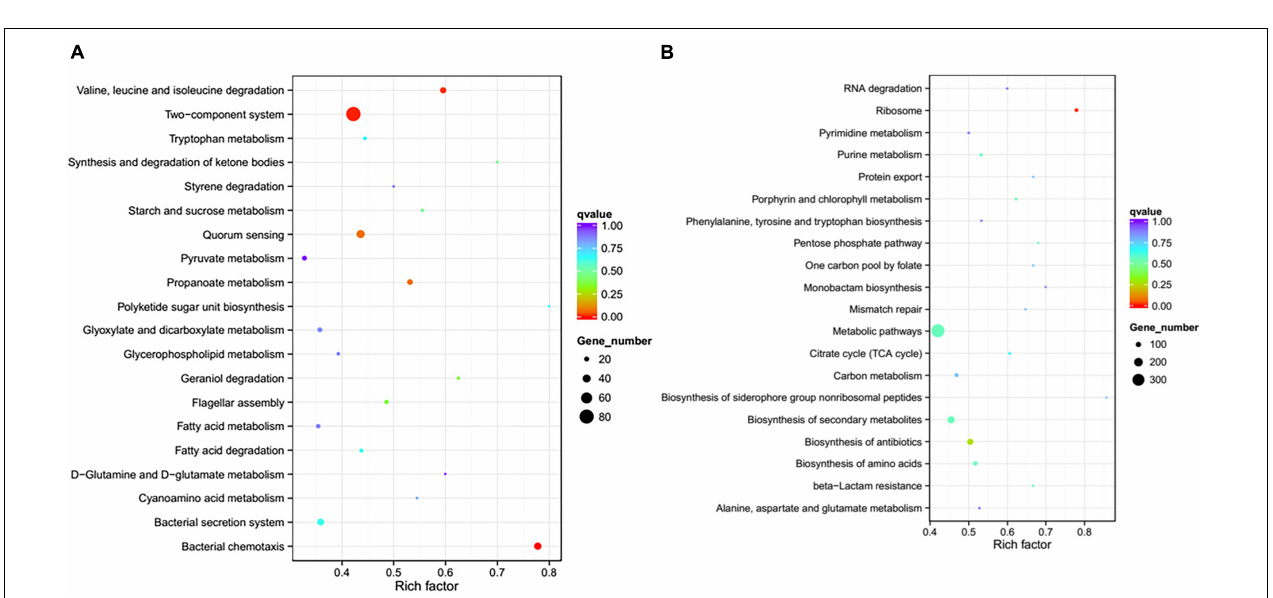
FIGURE 2 | Significantly enriched Gene Ontology categories ( q -value < 0.05) of differentially expressed genes based on RNA sequencing analysis of the DADS-treated group compared to the control group. Three main categories were identified: biological process, cellular component, and molecular function. (A) the most highly enriched GO terms; (B) the most highly enriched GO terms in the biological process